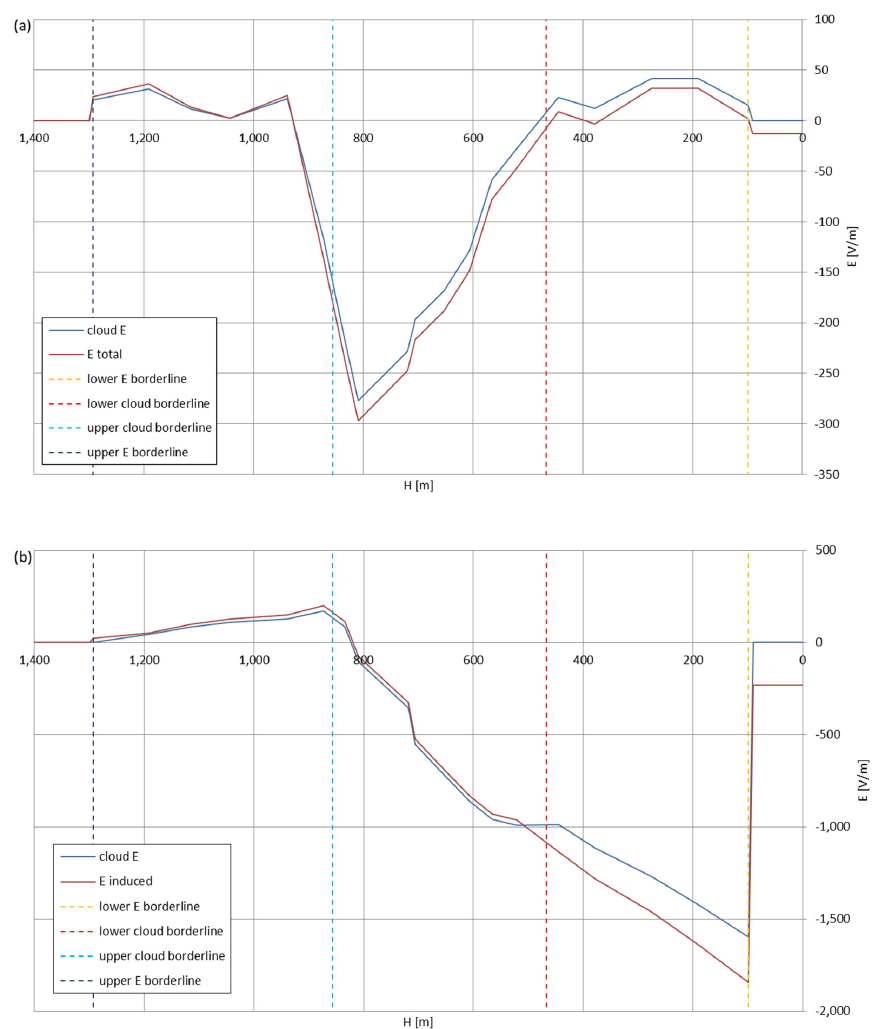
Figure 14. Maximum electric field strengths around the wire antenna re-entering through Stratocumulus cloud negatively polarized: ( a ) ‘static’ case and ( b ) ‘dynamic’ case.